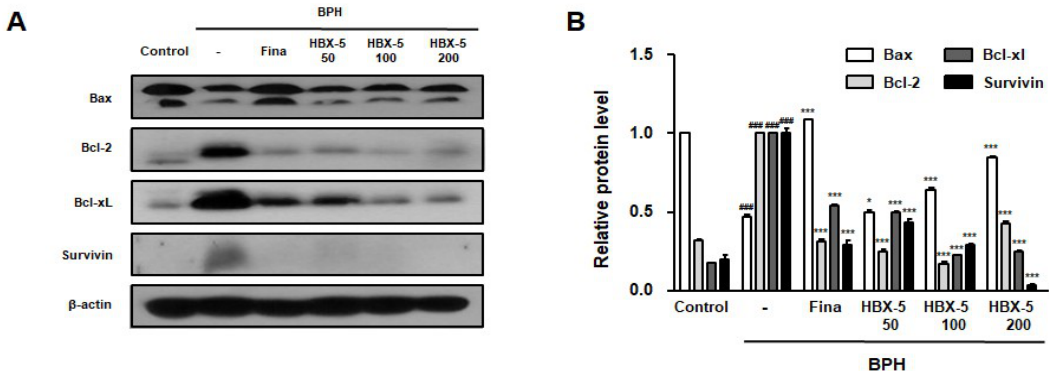
Figure 8. Effect of HBX-5 administration on the expression of apoptosis-related proteins in prostate tissues of rats with BPH models. ( A ) The expression levels of Bax, Bcl-2, Bcl-xL and Survivin were determined by western blotting using specific antibodies. β -actin was used as internal control. ( B ) The protein band densities were determined by densitometric analysis. The data showed representative mean ± standard error of the mean of 10 rats per group ( ### p < 0.001 vs. Control group; *** p < 0.001 vs. BPH group). Control, Control group; BPH, rats with BPH group; Fina, rats with BPH group treated with 5 mg/kg/day of finasteride; HBX-5 50, rats with BPH group treated with 50 mg/kg/day of HBX-5; HBX-5 100, rats with BPH group treated with 100 mg/kg/day of HBX-5; HBX-5 200, rats with BPH group treated with 200 mg/kg/day of HBX-5.